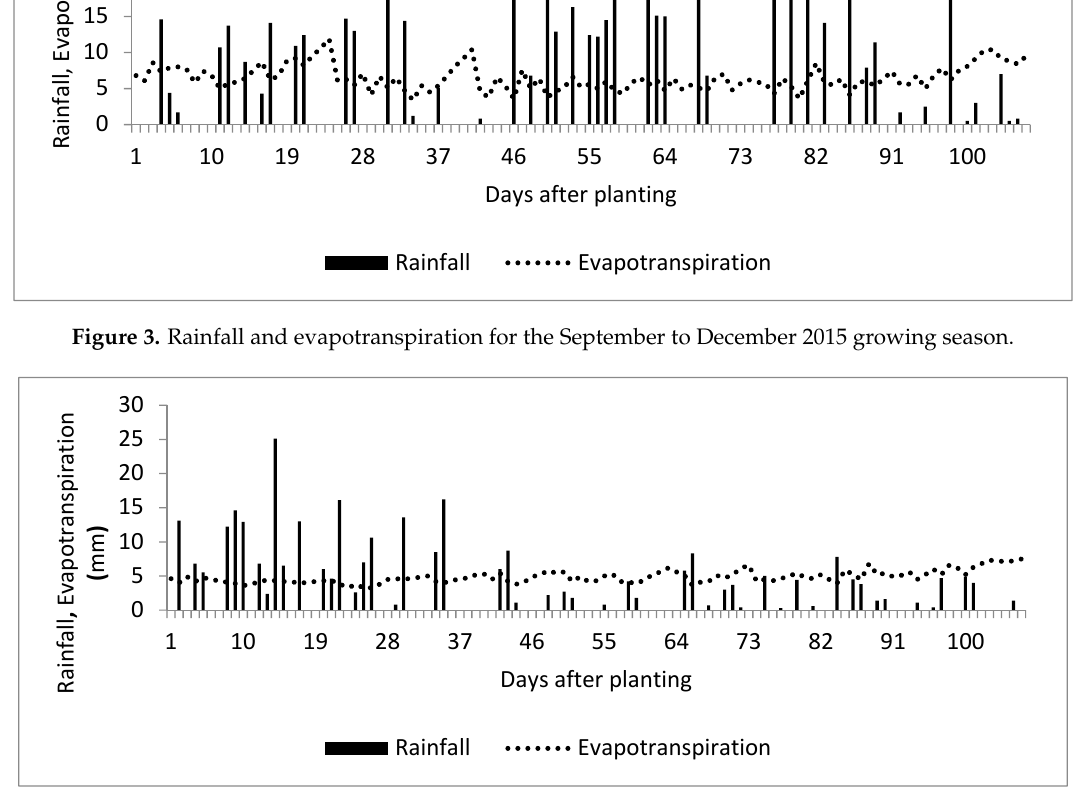
Figure 4. Rainfall and evapotranspiration for the March to July 2015 growing season.